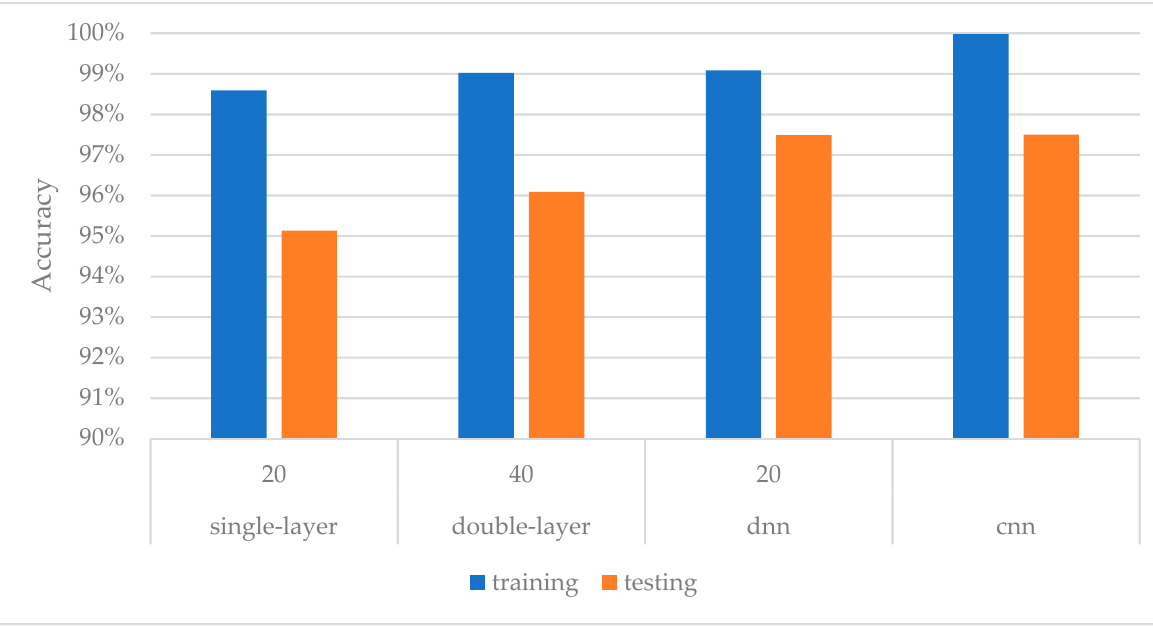
Figure 6. Multi shooting angle comparison among the four major NN methods.